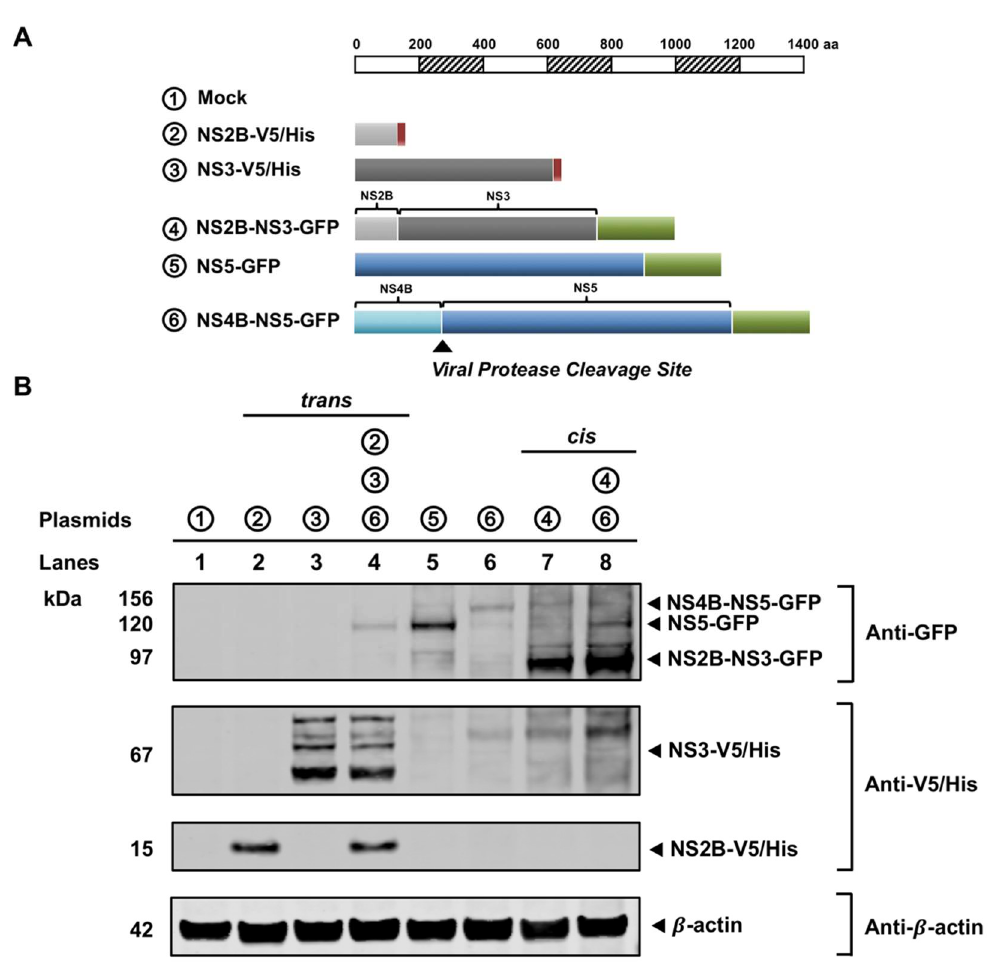
Figure 5. NS3 is a functional viral protease when NS2B is provided in trans. ( A ) Schematic diagram depicting the V5/His or GFP-tagged WNV NS constructs used in this proteolytic processing assay. Constructs are drawn to scale according to the number of amino acid residues. The V5 or GFP tags are indicated by red or green boxes, respectively. The viral protease cleavage site between NS4B and NS5 is marked by the black arrowhead. ( B ) HEK293T cells were transfected with various combinations of WNV NS constructs (listed at the top of the panel) and cell lysates were harvested 48 h post-transfection. Cleavage of NS4B-NS5-GFP by NS3-V5/His when NS2B was provided in trans (lanes 2–4) or in cis (lanes 7–8) was assessed by Western blotting using anti-GFP and anti-V5/His antibodies to detect the transfected viral proteins and cleaved products. β -actin served as an internal loading control. Molecular weights (kDa) are given on the left side of each panel.